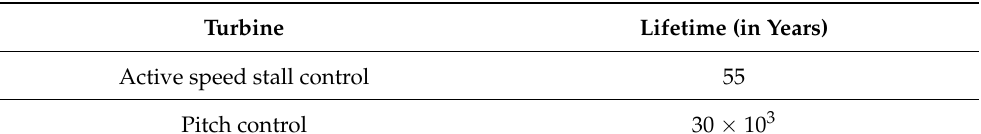
Table 7. IGBT lifetime comparison between active speed stall-controlled and pitch-controlled tur- bines.